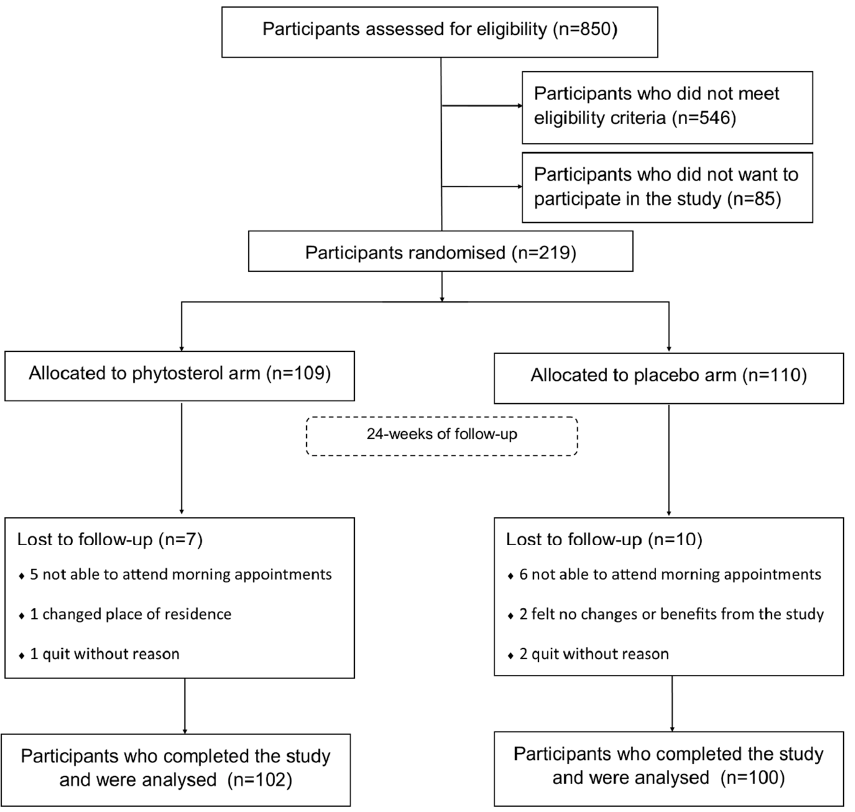
Figure 2. Flow chart of the study. Table 2. Baseline participants’ characteristics by the